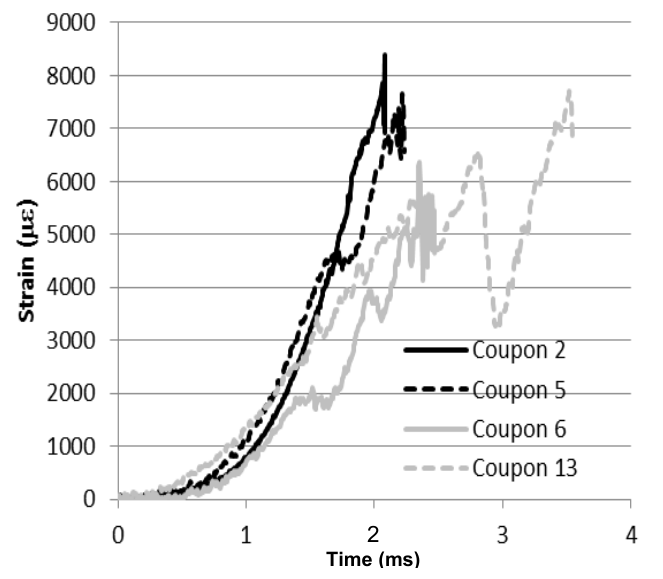
Figure 11. Strain vs. time graphs for four representative coupons.